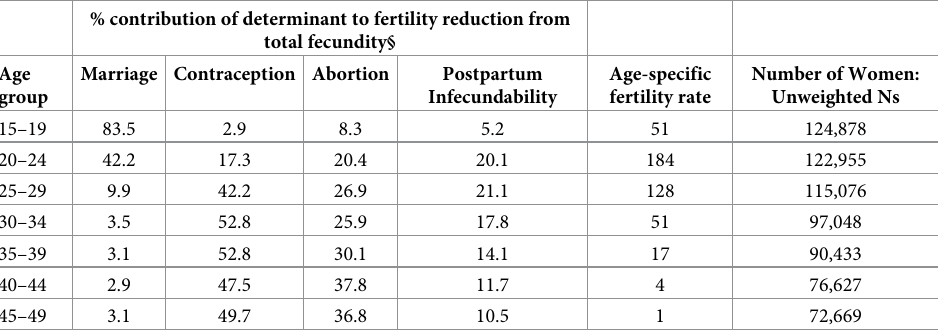
Table 2. Estimates of the percent contribution of four key proximate determinants to fertility reduction by age- group, actual ASFR and number of women: India 2015–16. % contribution of determinant to fertility reduction from total